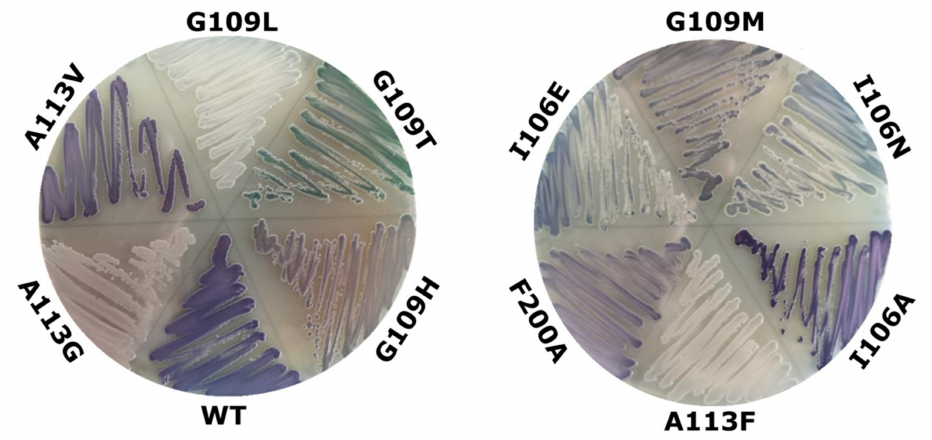
Figure3. Theformationofindigo-likepigmentsbyisolatedPMLmutants. Onlythemostdistinguishable variants are presented. Luria-Bertani (LB) plates were supplemented with 0.5 mM